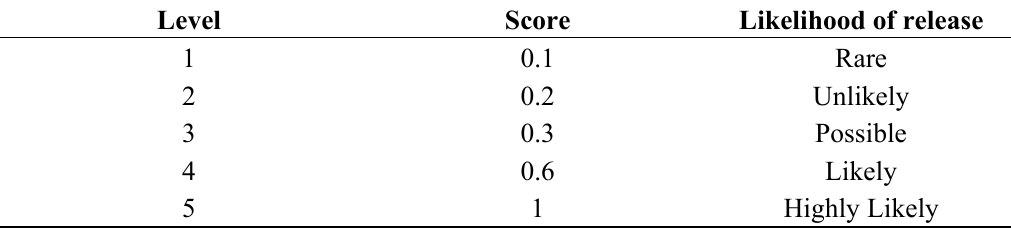
Table 2. Levels of likelihood of release.